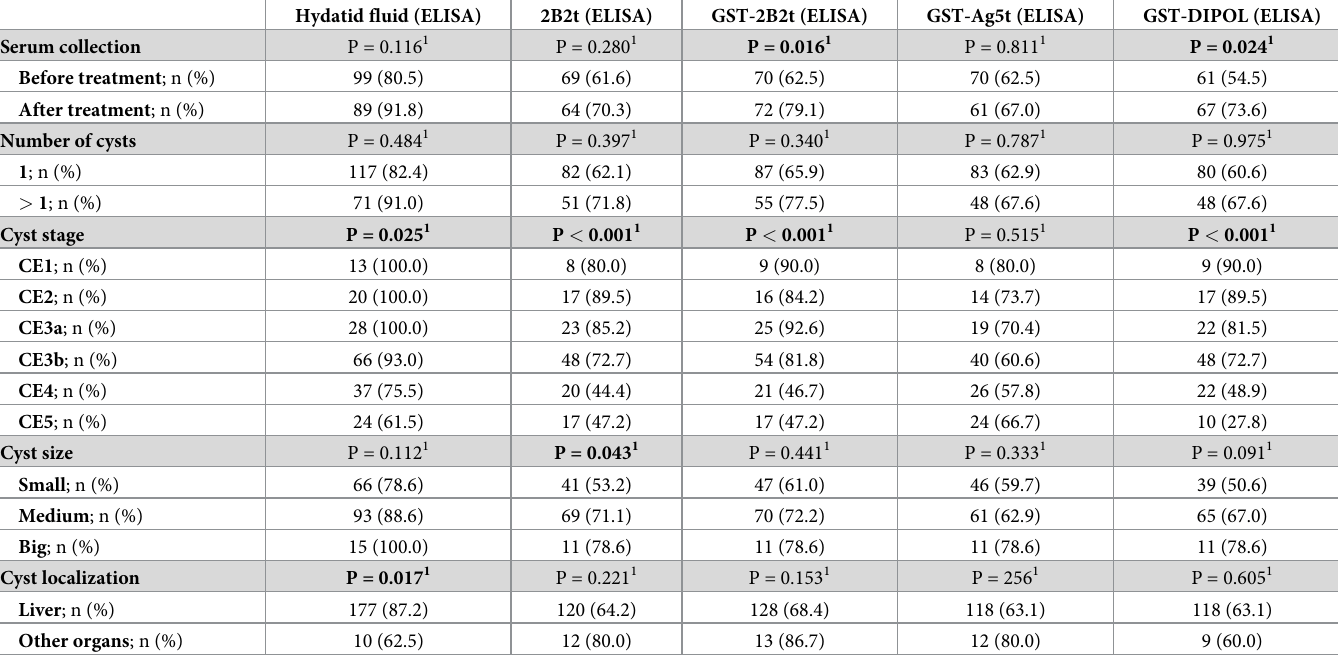
Table 4. Sensitivity of the serological tests according to different clinical characteristics.